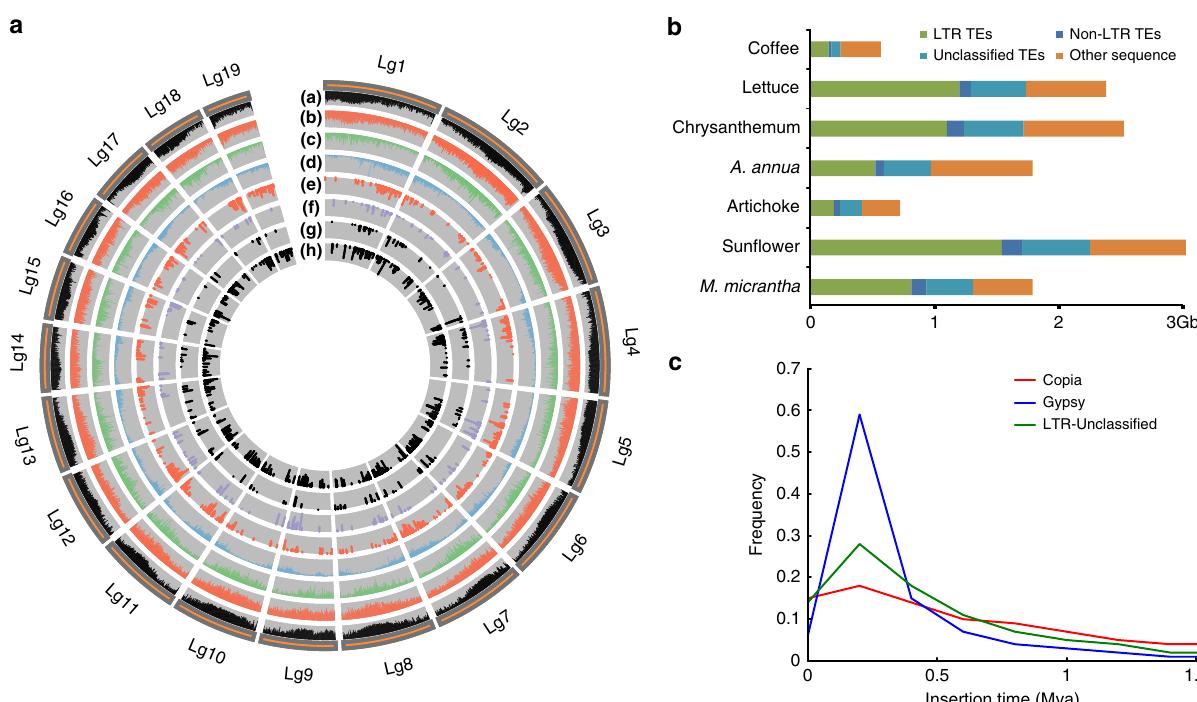
Fig. 1 Landscape of the Mikania micrantha genome. a Integration of genomic and expression data. (a) Distribution of GC content; (b) distribution of the Gypsy family of long terminal repeats retrotransposons (LTR-RTs); (c) distribution of the Copia family of LTR-RTs; (d) distribution of coding genes; (e – h) expression of organ-speci fi c genes (from outside to inside tracks: root, stem, leaf and fl ower). b Comparison of repetitive sequences in asterids, including Mikania micrantha , sun fl ower ( Helianthus annuus ), artichoke thistle ( Cynara cardunculus ), Artemisia annua , chrysanthemum ( Dendranthema morifolium ), lettuce ( Lactuca sativa ), and coffee ( Coffea canephora ). c The insertion time distribution of intact LTRs in the M. micrantha genome. Mya indicates million years